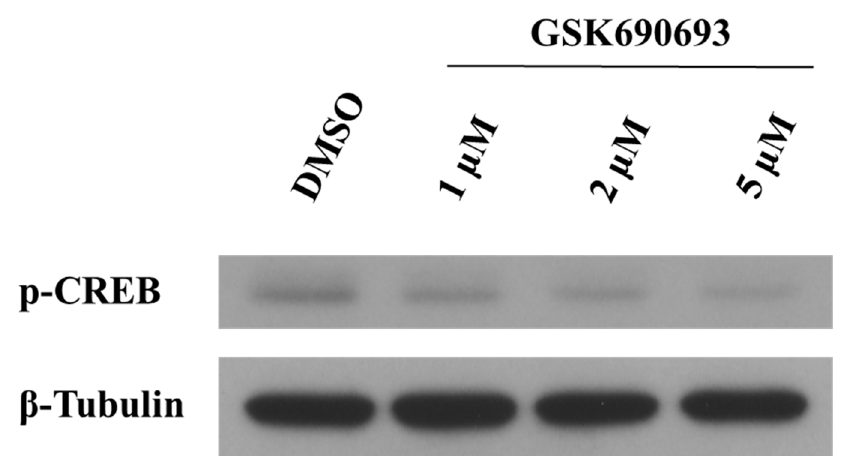
Figure A6. Modulation of CREB phosphorylation (Ser133) by GSK690693 shown as representative Western blot.